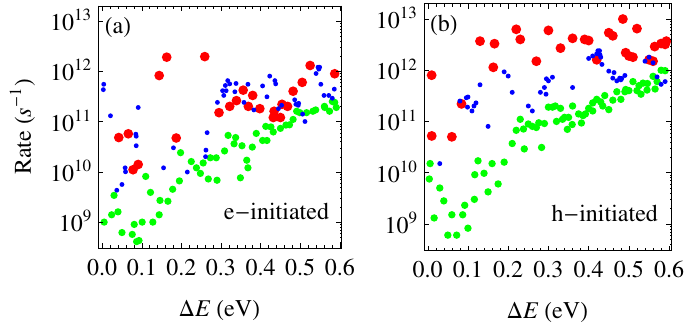
Figure 5. Calculated rates of the exciton generation initiated by highly excited ( a ) electron and ( b ) hole (as shown in Figure 4) in Si 317 X 172 crystallite for X = H (small blue dots), X = Cl (medium green dots) and X = Br (big red